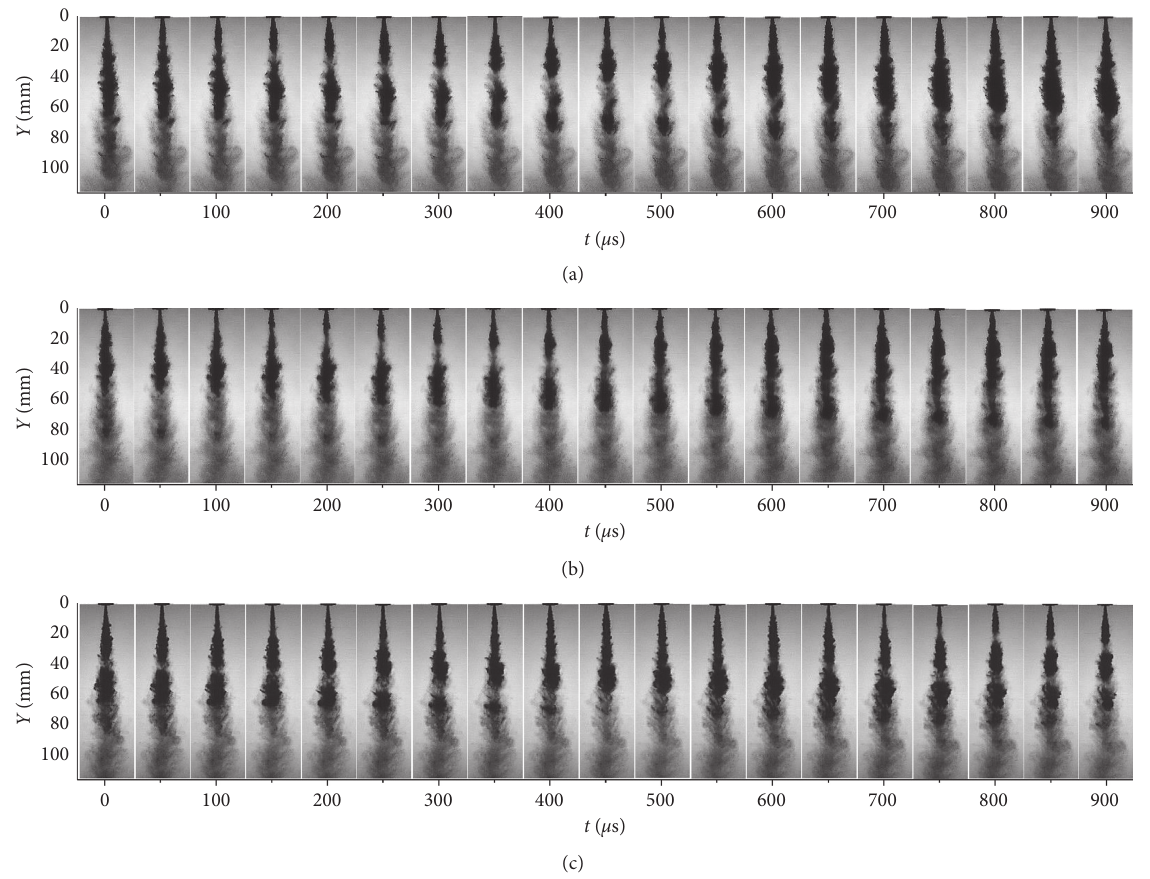
Figure 6: Cavitation cloud distribution of three different nozzles ( σ � 0 . 0062). (a) Divergent angle α � 40 ° . (b) Divergent angle α � 80 ° . (c) Divergent angle α � 120 °